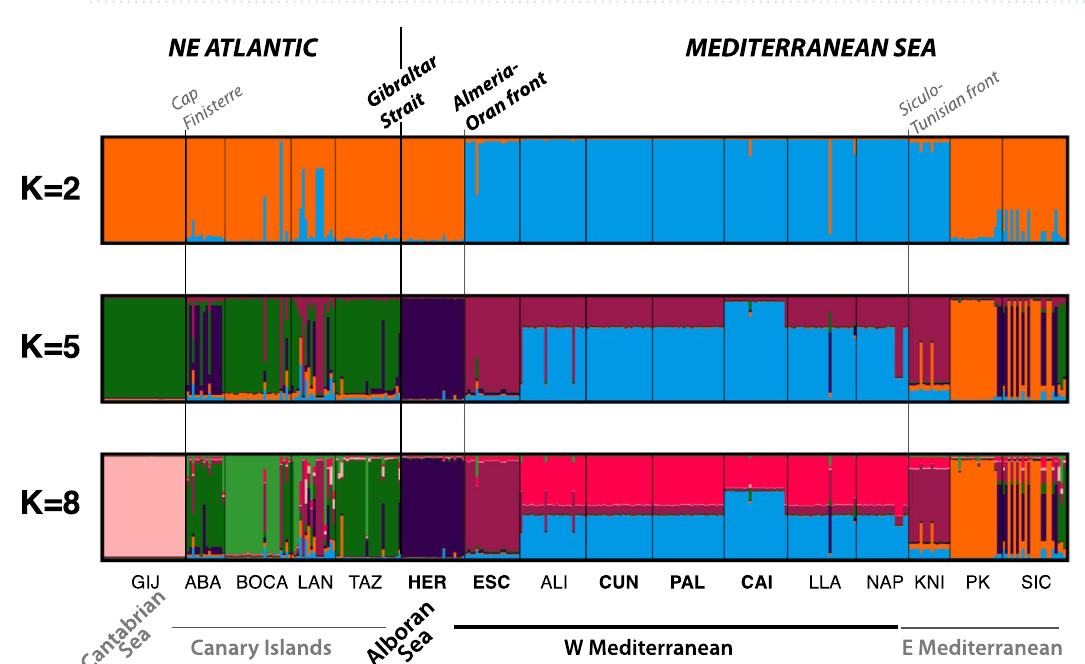
Figure 5. Barplots from the Bayesian clustering analysis obtained in STRU CTU RE for K = 2, K = 5 and K = 8, from the whole dataset including all individuals. Major oceanographic areas and fronts are